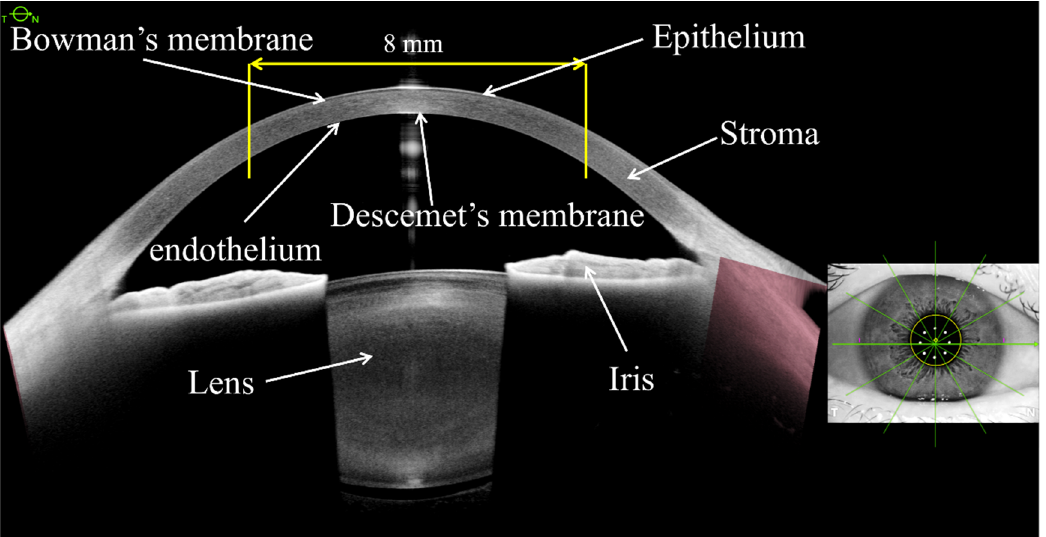
Figure 1. The cross-sectional image and corresponding ocular tissue information of anterior segment and corresponding scanning directions on the eye image using ANTERION device. The central 8 mm-diameter cornea area centered on corneal vertex based on 65 radial scanning lines was used for corneal curvature analysis.